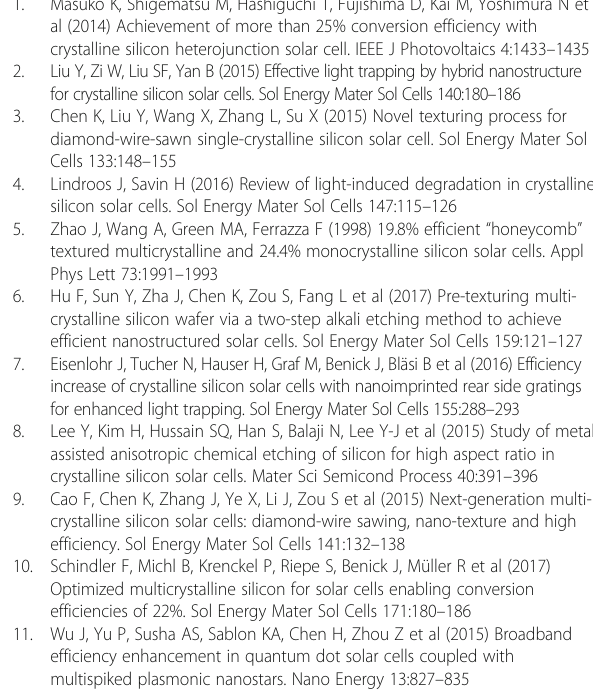
Additional file 1: Figure S1. Morphology comparison of silicon wafers processed in MACE with and without additive C: (a) with additive C, front view; (b) without additive C, front view; (c) without additive C, oblique view. (DOCX 1014 kb)